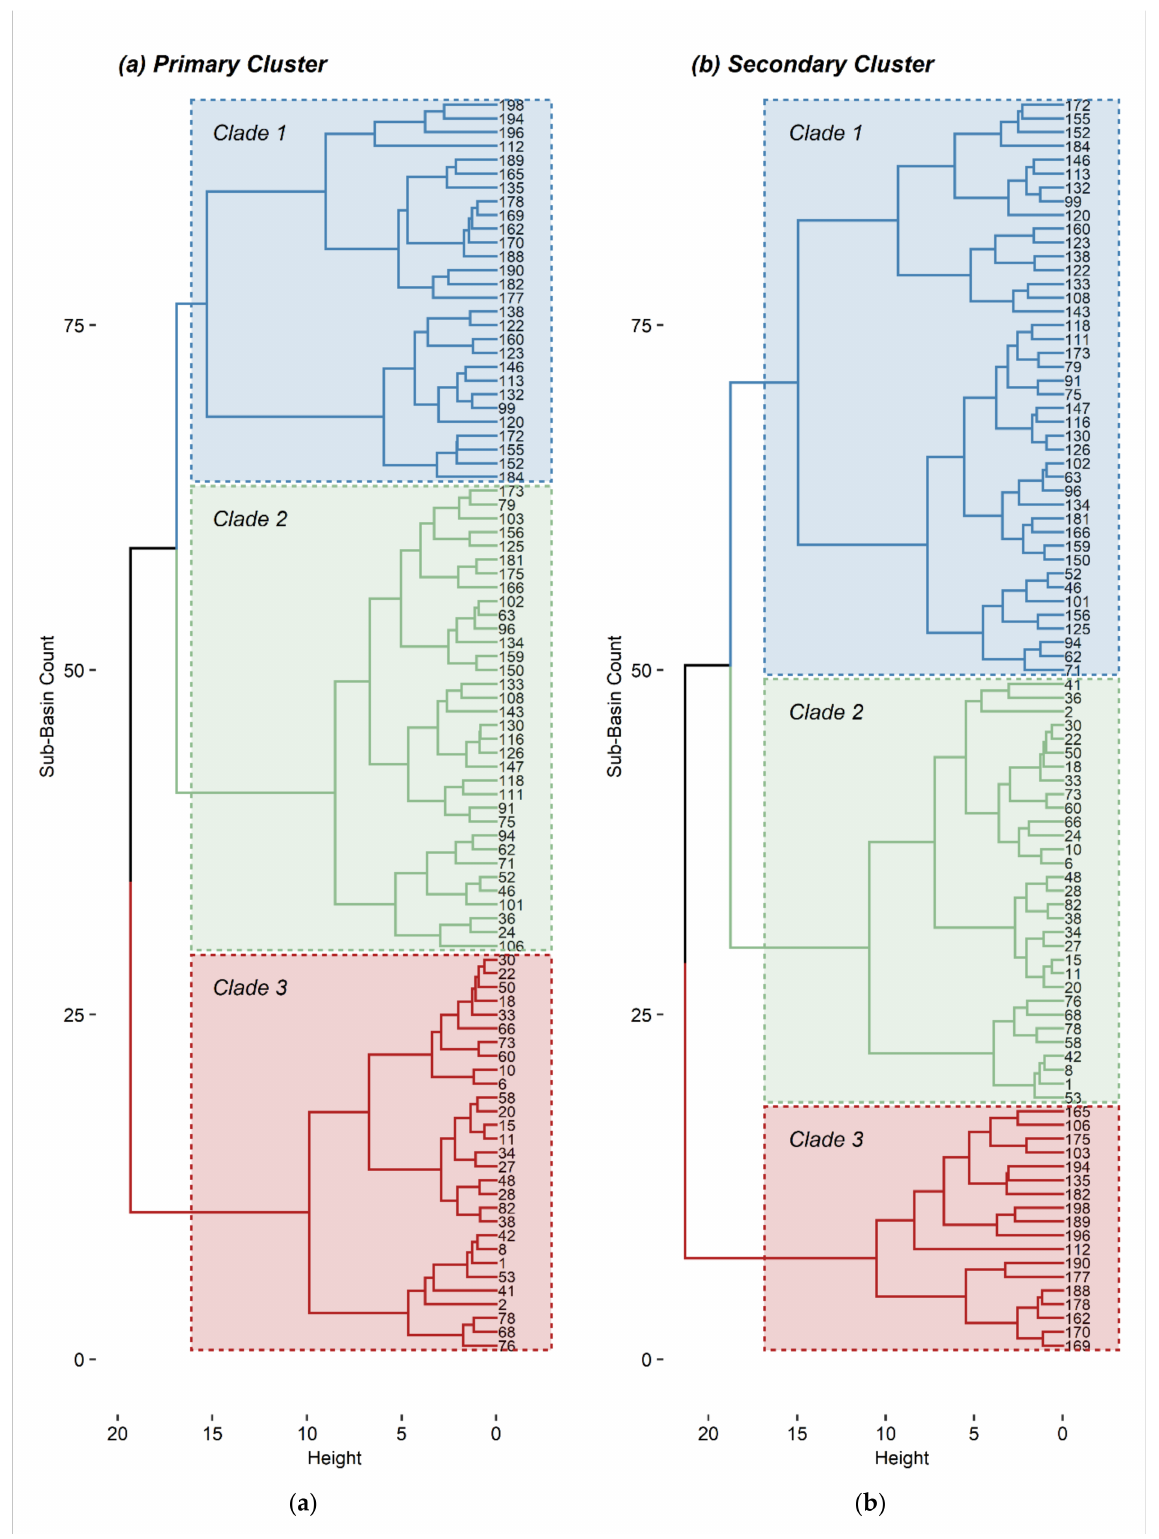
Figure 7. The two cluster dendrograms showing the division of the three clades and their respective sub-basins, for ( a ) the primary cluster developed using only the structural and biophysical variables, and ( b ) the secondary cluster developed using a combination of the selected structural and biophysical variables and selected hydrologic